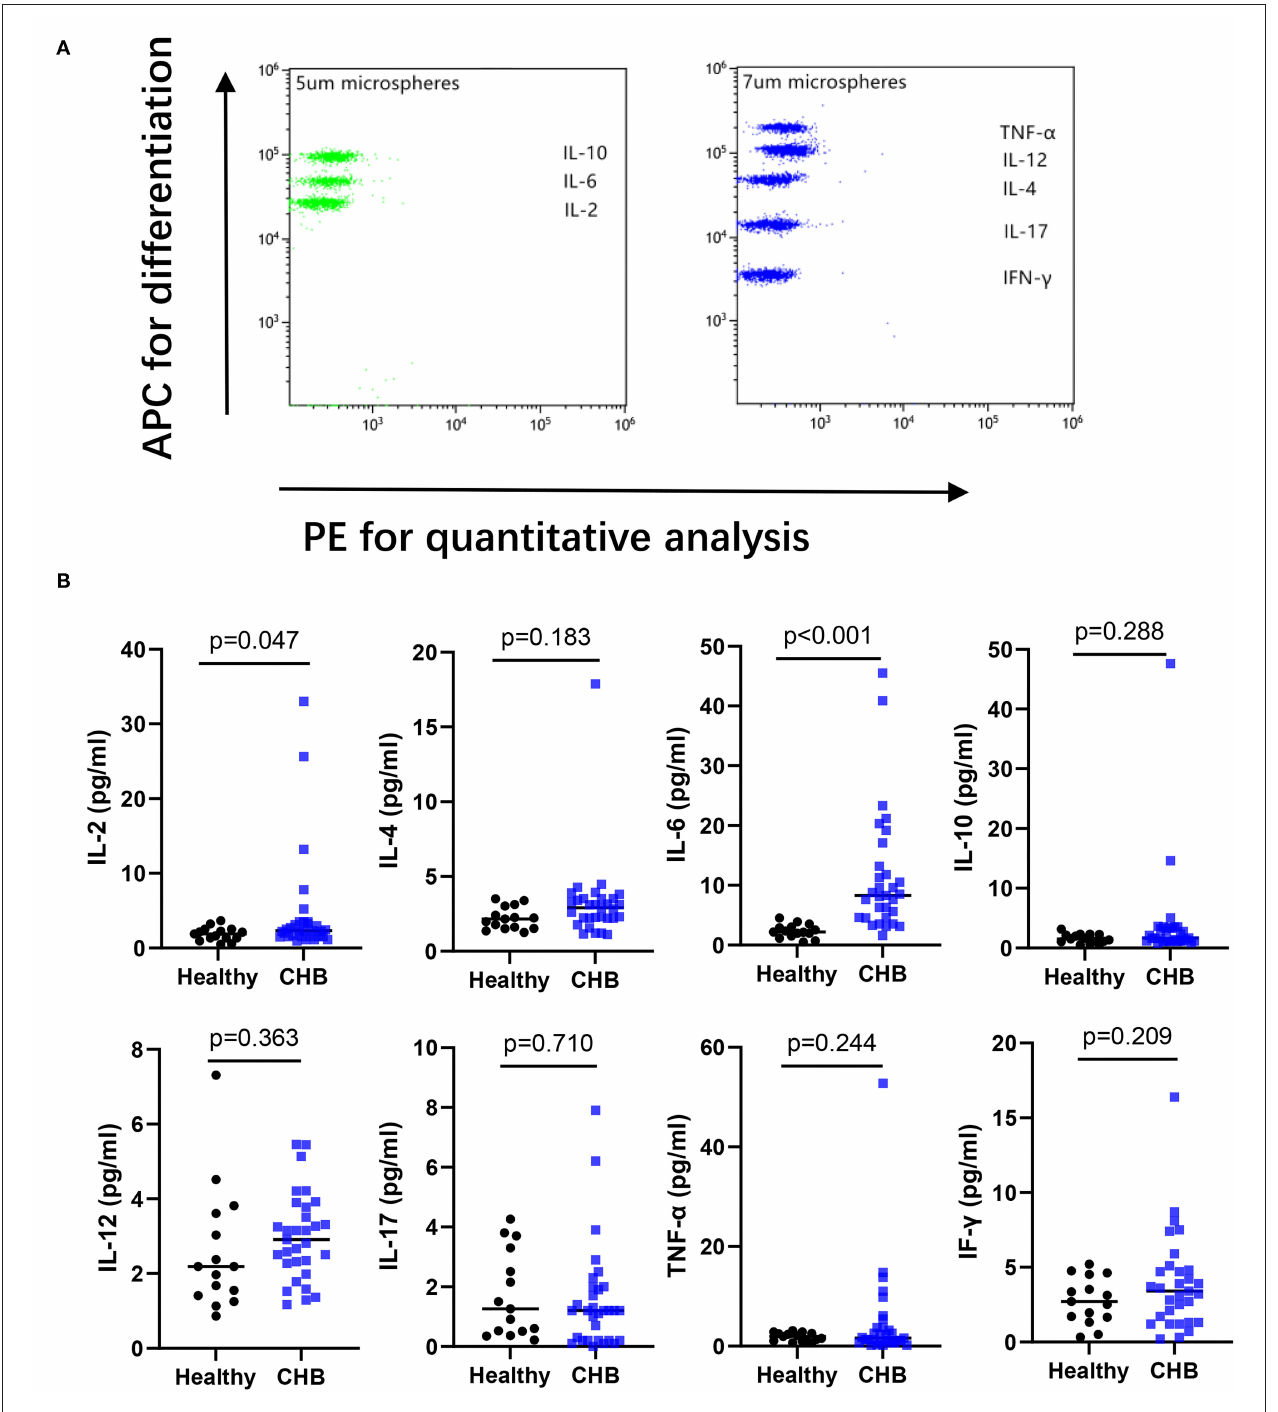
FIGURE 6 | Analyzing the cytokines in plasma by flow cytometry. (A) An example of cytokine test by Cytometric Bead Array from healthy controls. (B) The concentration of IL-17, IFN- γ , IL-2, IL-6, TNF- α , IL-12, IL-10, IL-4 between healthy ( n = 15), and CHB patients ( n = 31) were compared.